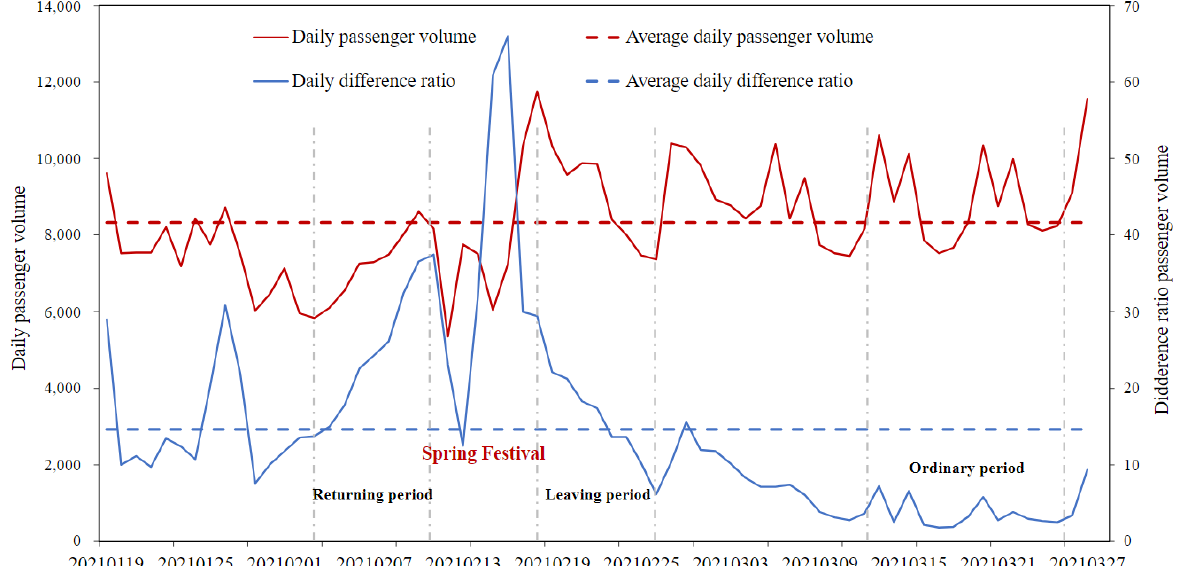
Figure 4. Passenger volume from January to March during the Spring Festival in